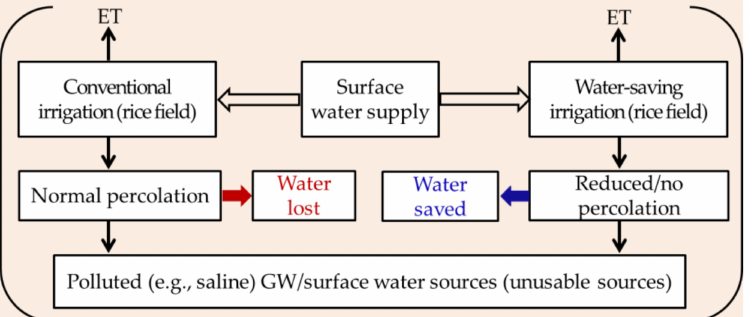
Figure 5. Water loss and water saving issues under conventional and water-saving irrigation from surface water sources when underground aquifer contains polluted water (e.g.,